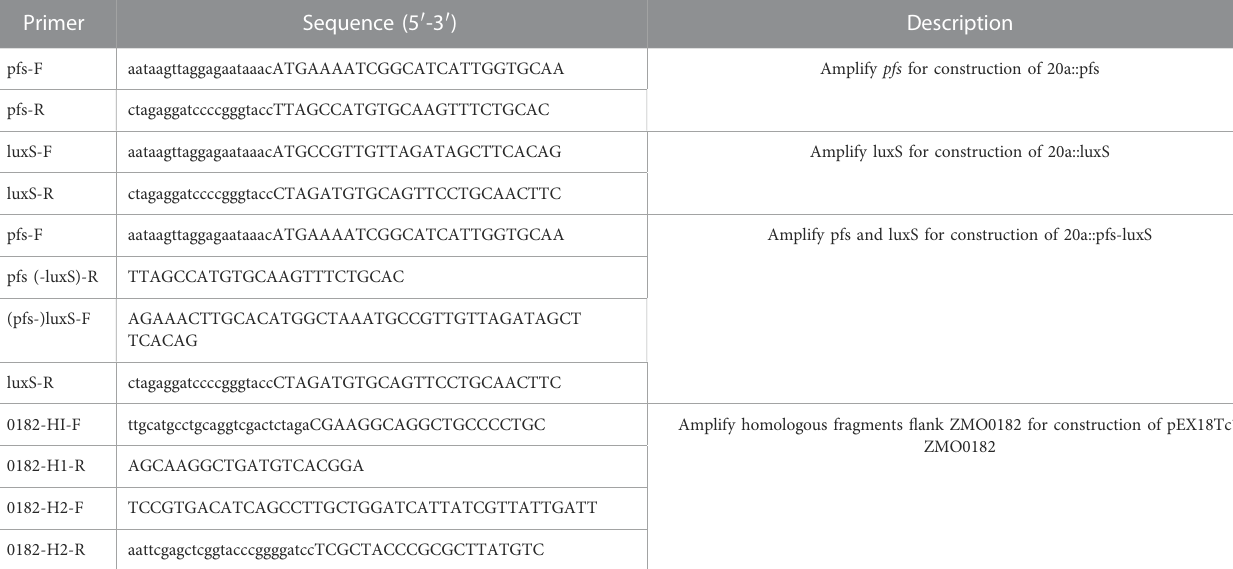
TABLE 2 Primers used in this